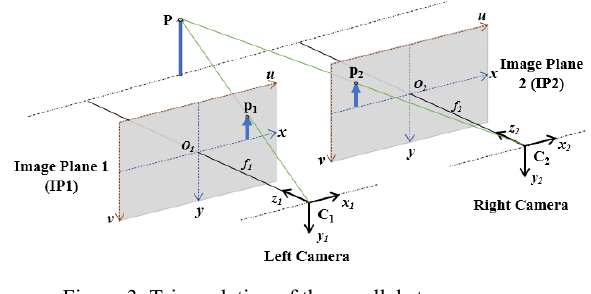
Figure 3. Triangulation of the parallel stereo